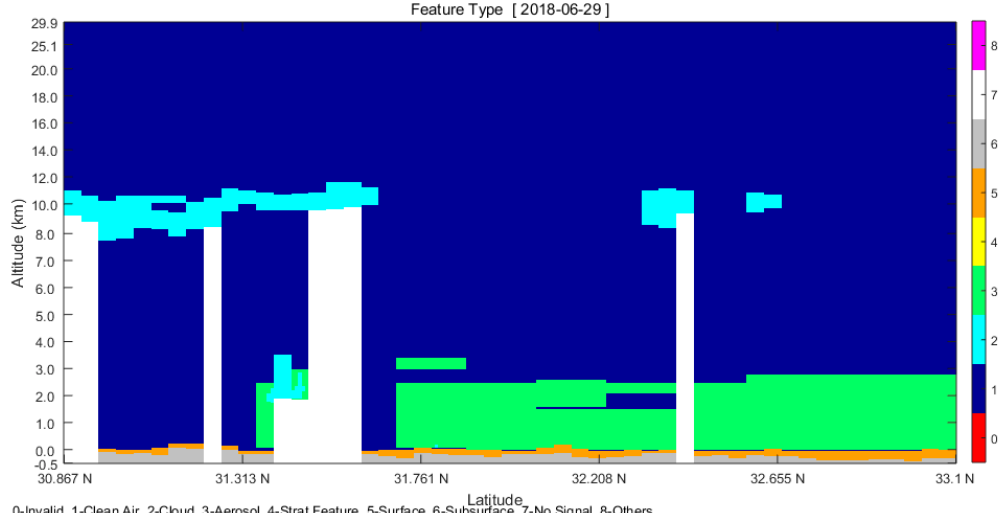
Figure 11. The feature type of aerosols.